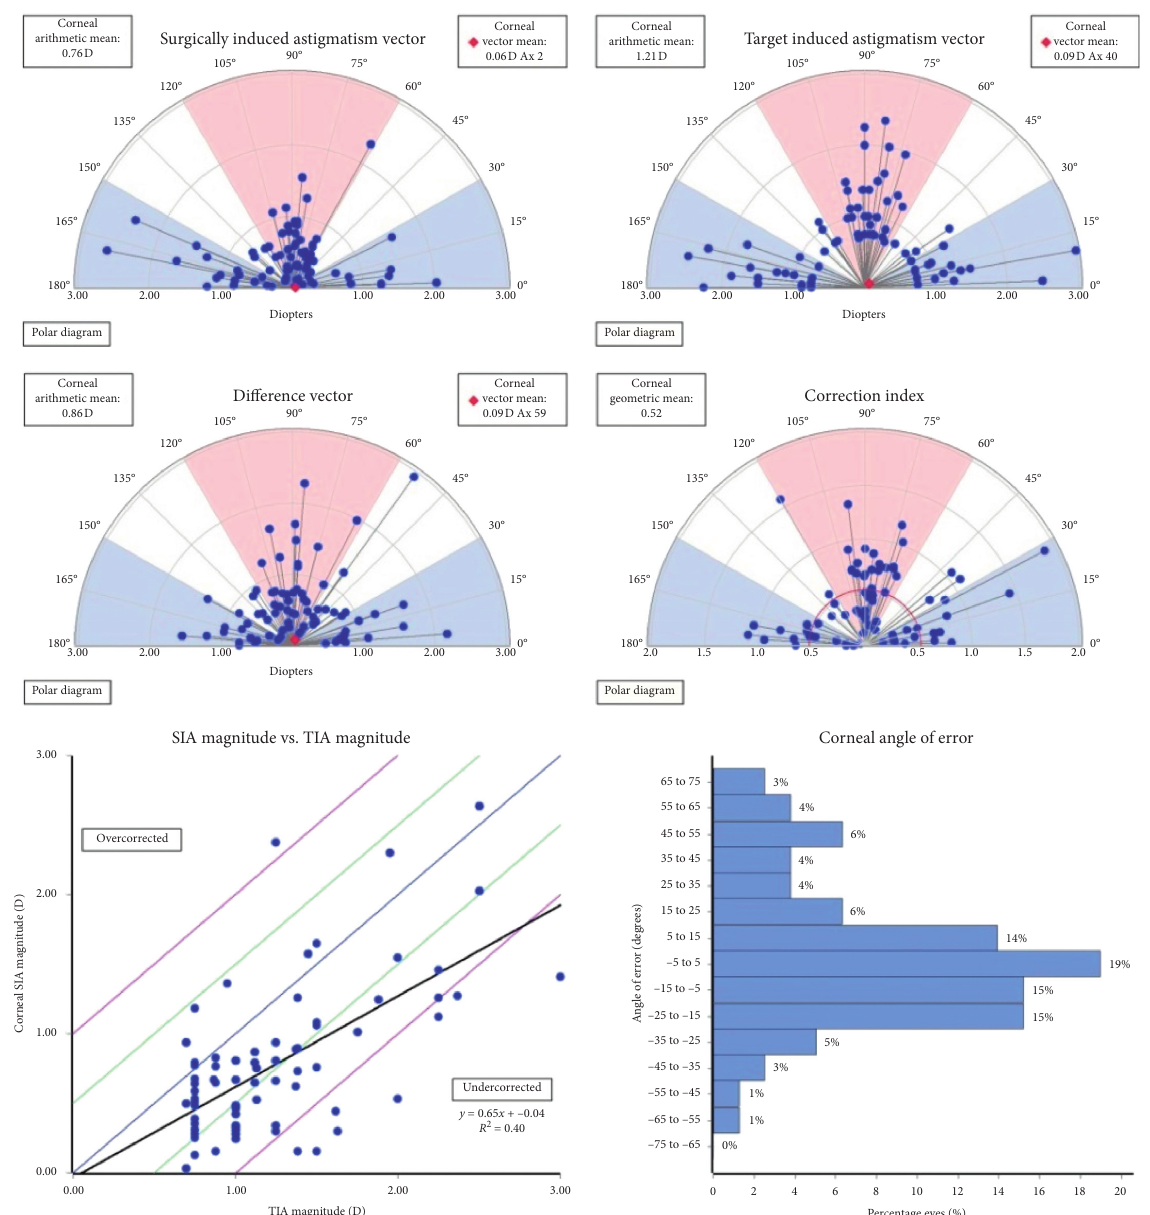
Figure 1: Outcomes of vector analysis by comparison of the preoperative with the postoperative (three months)